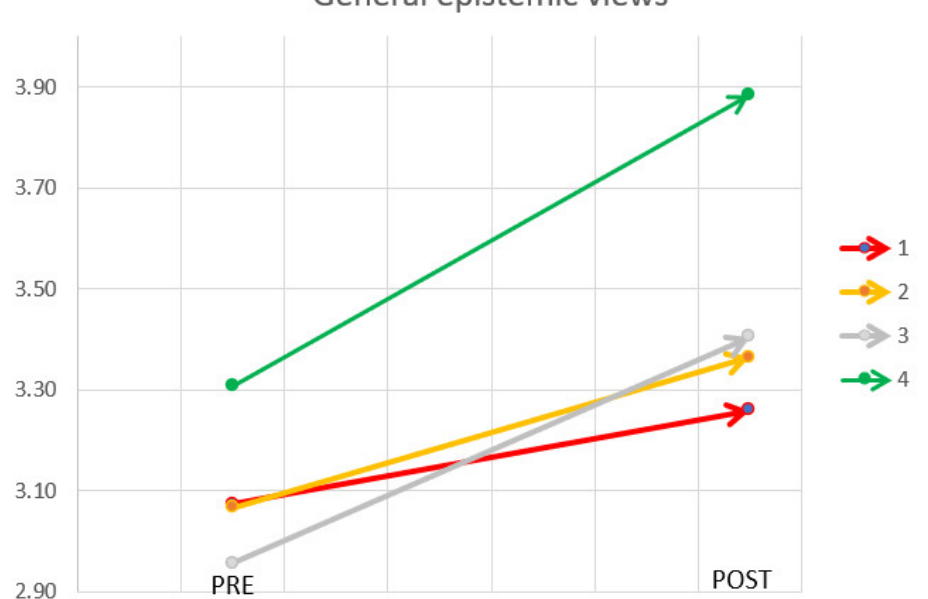
Figure 8. Pre-instruction vs. post-instruction average scores of the views about quantum technologies (VAQT) instrument (general epistemic views) according to the performance in the QTI for four groups (see Table 3).